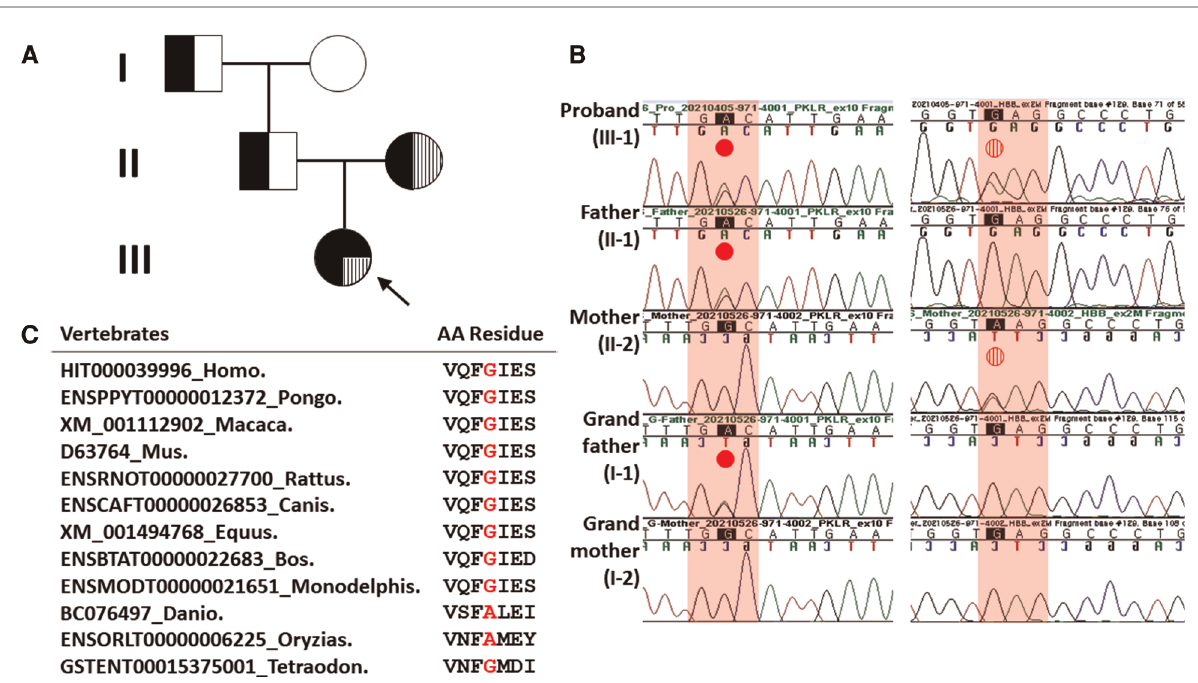
FIGURE 1 Pedigree analysis and Sanger sequencing results of heterozygous missense HBB and PKLR mutations in the proband and her family members. ( A ) Family pedigree showing that heterozygous missense HBB mutation and PKLR variant in the proband were inherited in trans , respectively. Solid black dot, PKLR variant; fi lled vertical line, missense HBB mutation. ( B ) In the left column, a missense PKLR variant (NM_000298.6: c.1607G>A, p.Gly536Asp) was inherited with a paternal origin (indicated by solid red dot). In the right column, a missense mutation (NM_000518.5: c.79G>A, p.Glu27Lys; rs33950507) of the HBB was inherited with a maternal origin (indicated by vertical striped red dot). ( C ) Sequence alignment of the PKLR protein in multiple vertebrate species. Protein sequence of the Gly536 residue is highly conserved between Human and Tetraodon except Danio and Oryzias analyzed by Evola (http://www.h-invitational.jp/evola/). It is highlighted in the red